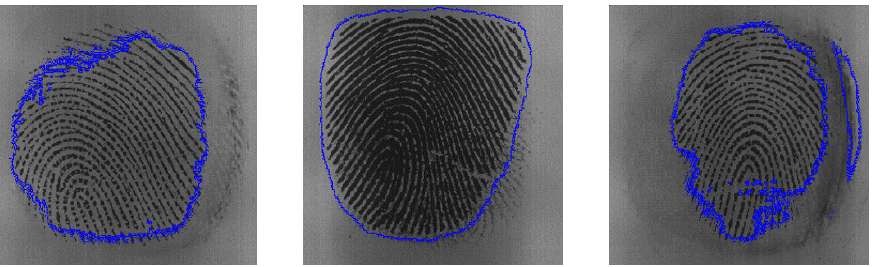
Figure 22: Segmentation results of three fingerprints from FVC2002 DB3 using the algorithm in [1].